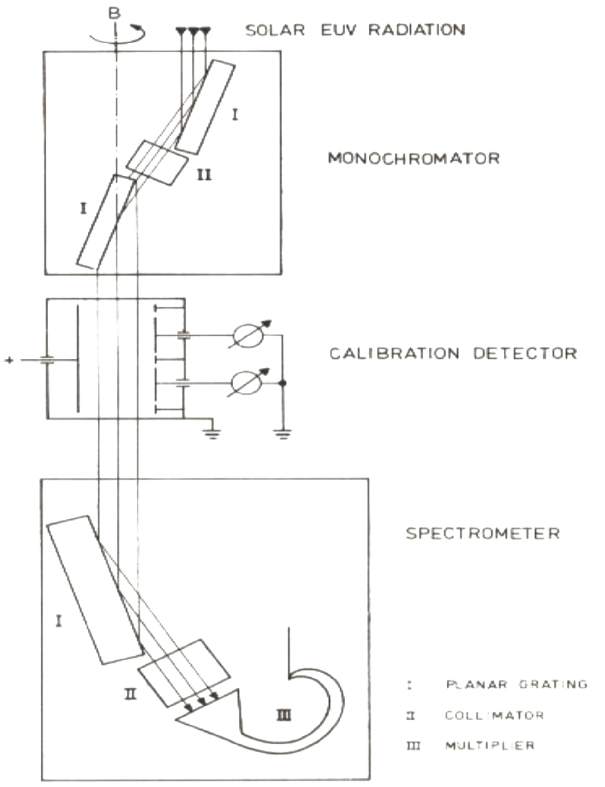
Figure 21. Instrumental arrangement for in-flight calibration of XUV spectrometers (Schmidtke, 1976b; copyright permission granted by De Gruyter Rights & Licenses